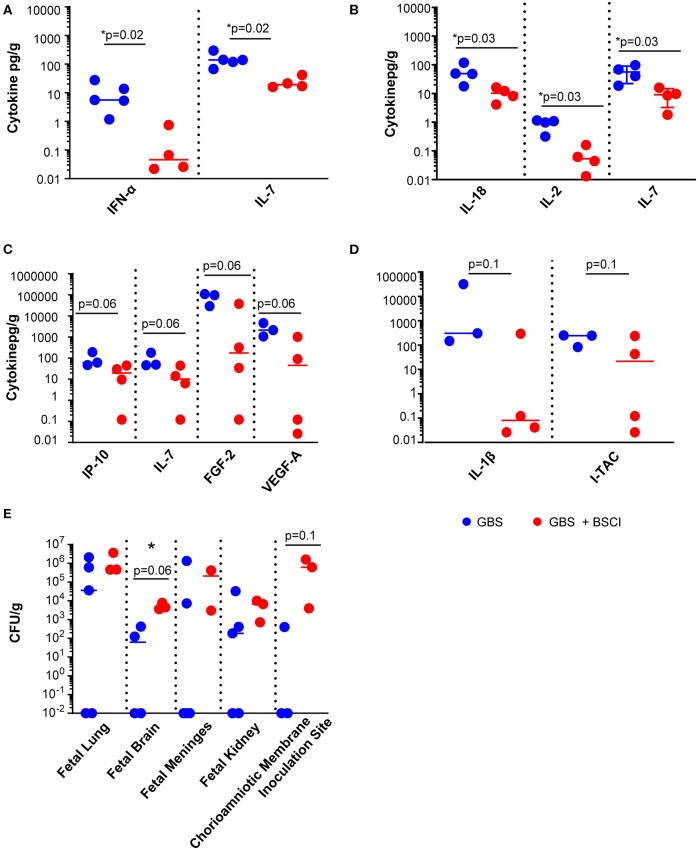
BSCI treatment was associated with a reduction in cytokines and chemokines, but increased CFU counts in fetal tissues. Luminex analysis was performed on (A) lung, (B) brain, and (C,D) chorioamniotic membrane lysates from GBS-infected animals (solid blue circles) and those that received GBS plus BSCI (solid red circles). The CFU counts per gram of tissue (E) are shown from GBS-infected animals (solid blue circles) and those inoculated with GBS plus BSCI (solid red circles). *p < 0.05, Wilcoxon rank sum test.